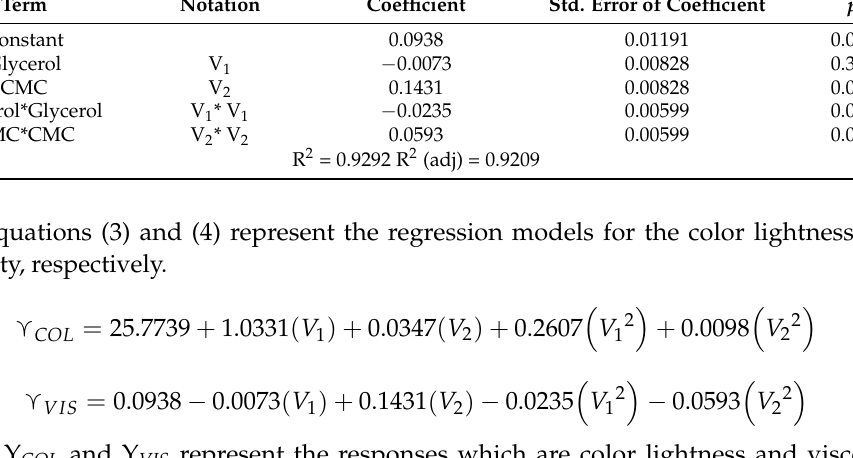
Table 6. Estimated effects and coefficient for glycerol and CMC on the viscosity test